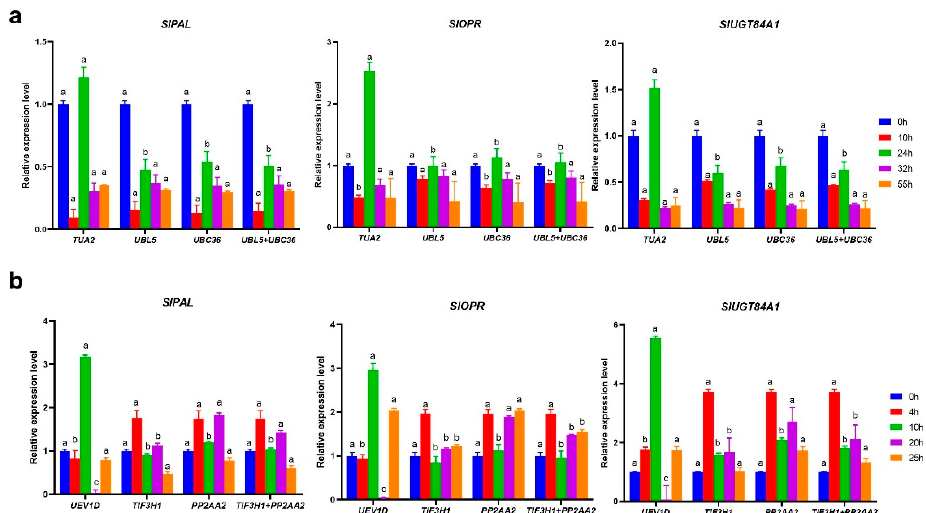
Figure 4. Relative expression patterns of target genes. ( a ) UV treatment, ( b ) SA treatment. The most stable reference genes ( UBL5 and UBC36 for UV; TIF3H1 and PP2AA2 for SA), and unstable genes ( TUA2 for UV and UEV1D for SA) were selected for normalizing RT-qPCR data. Data are provided as mean ± SD; all RT-qPCR procedures were performed in triplicate for technical and biological replicates. Note: Different lowercase letters indicate significant differences at 0.05 levels.